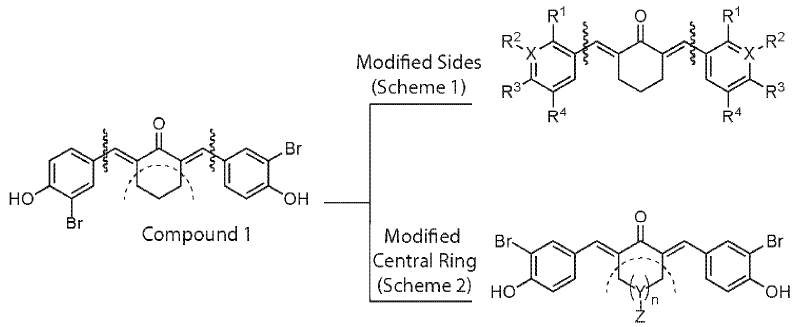
Figure 1. Two-pronged approach to synthesize chemical analogues of a cy- C 5 -curcuminoid compound 1 . In Scheme 1, Montmorillonite K-10 clay was utilized with microwave assisted organic synthesis (MAOS) to synthetically generate the analogs of cy-C 5 -curcuminoid with modification on sides (K-10/MAOS). In Scheme 2, synthetic methods were used to modify the central ring of cy - C 5 -curcuminoid for generating new analogs.